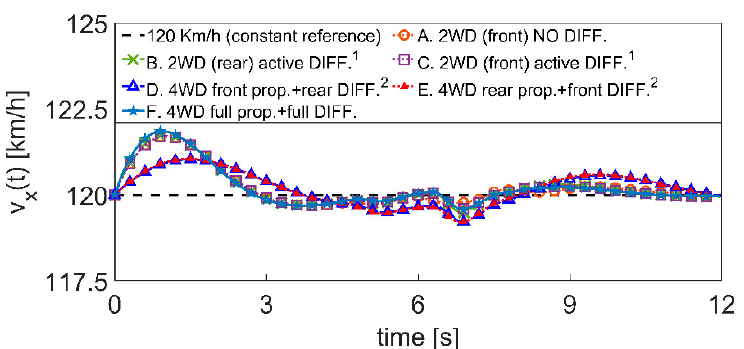
→ → d ( b ) },C{ d ( g ) }) and 2 (D{